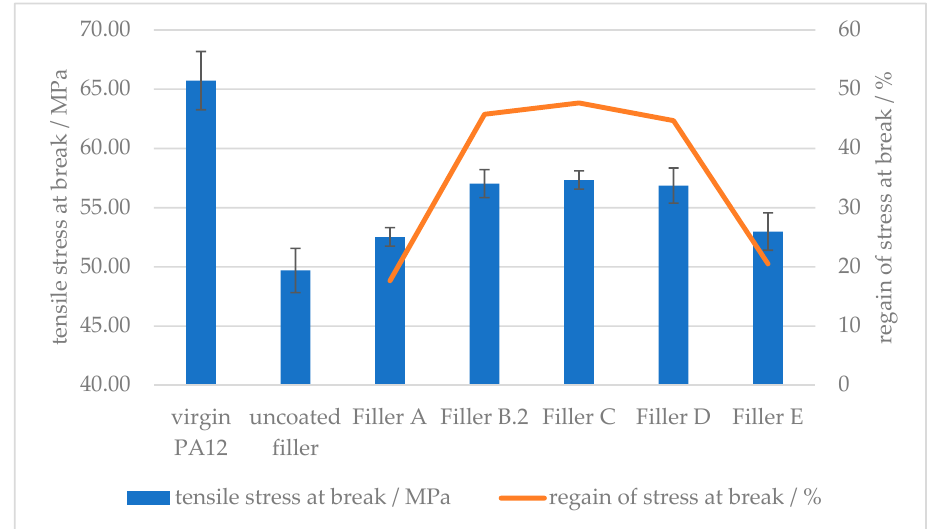
Figure 10. Effect of the surface modifier chemistry on the elongation at break of ( B ) amino hexanoic acid; ( C ) ε -caprolactam; ( D ) L -arginine; ( E ) glutamic acid treated CaCO 3 -filled PA12 composites. Polymers 2020 , 12 , x FOR PEER REVIEW